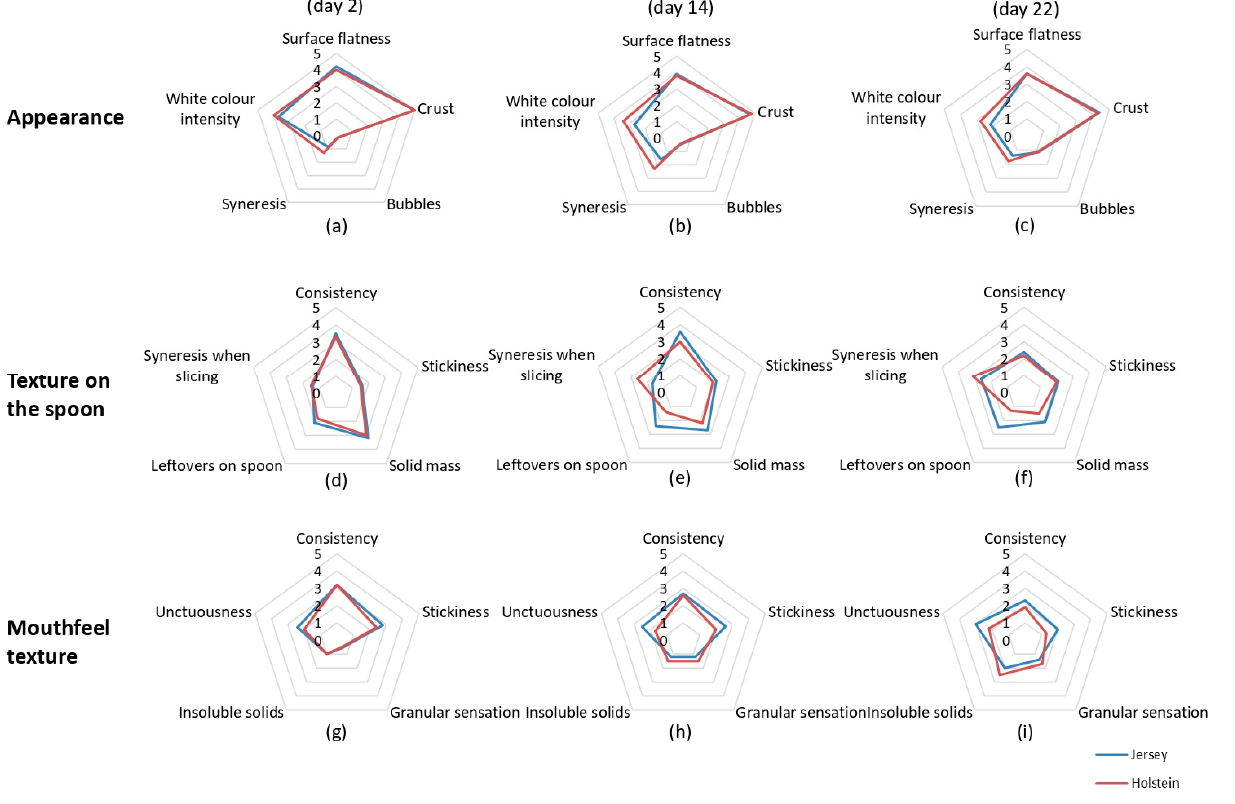
Figure 1. Appearance ( a – c ), texture on the spoon ( d – f ) and mouthfeel ( g – i ) of traditional-type Greek yoghurts made with Jersey or Holstein Friesian milk.